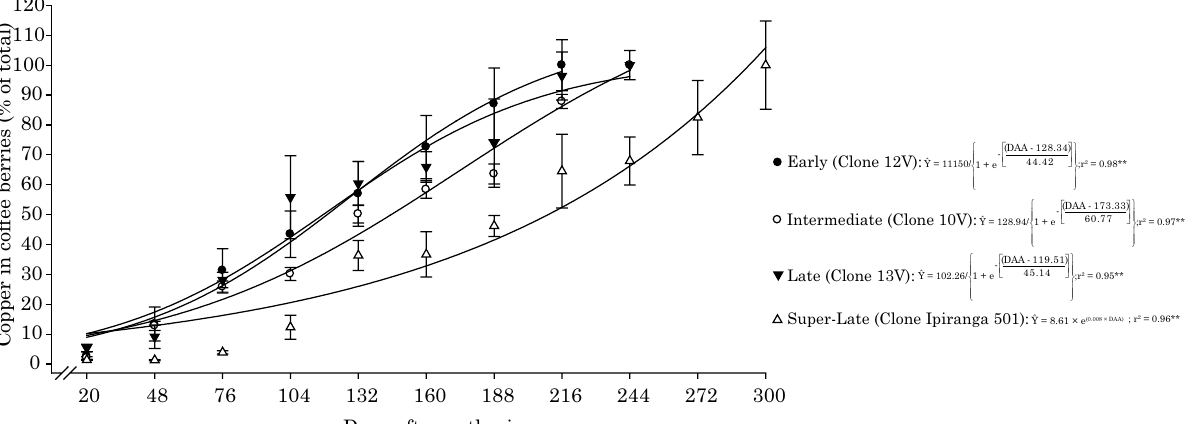
figure 2. copper accumulation in berries (as a percentage of total accumulation) of four genotypes (clones) of ‘conilon’ coffee, from anthesis to fruit maturation. Bars represent standard deviation of the mean. **: significant at 1 %.